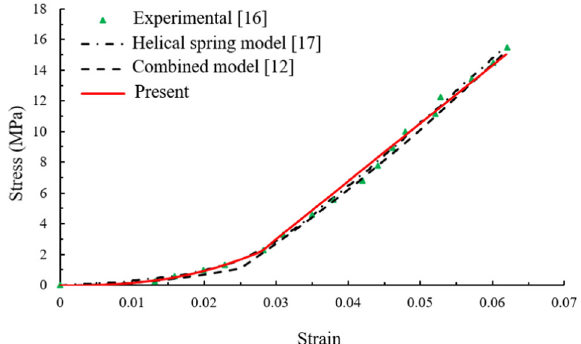
Fig. 2 Constitutive behavior of bovine Achilles Table 1 The identi fi ed parameters for the bovine Achilles tendon Parameters